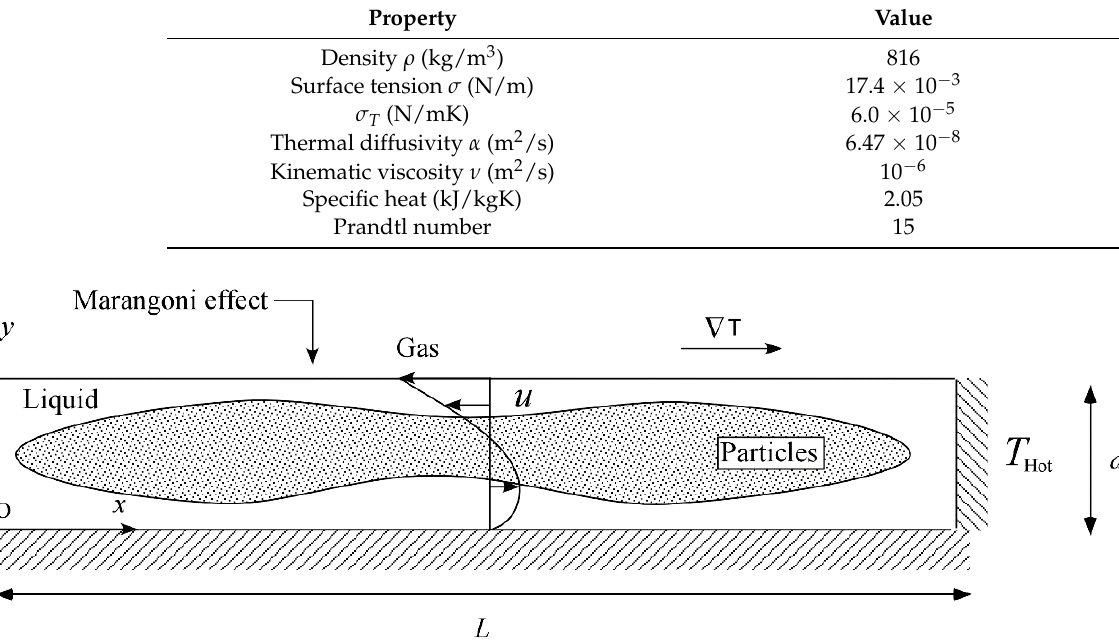
Table 2. Physical properties of 1 cSt silicone oil at 25 ◦ C.